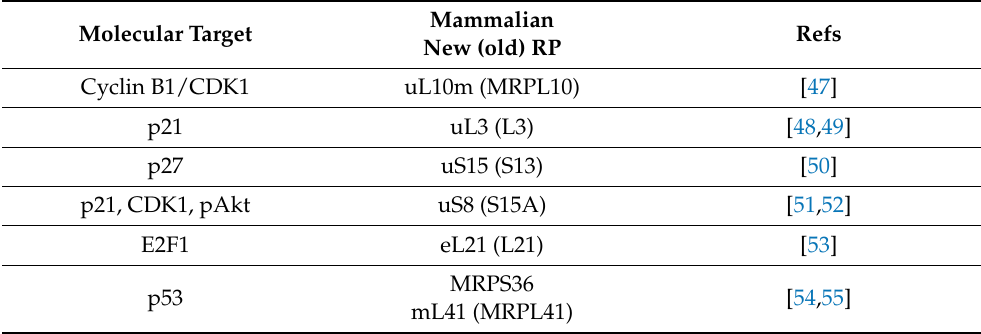
Table 2. RPs regulate cell cycle